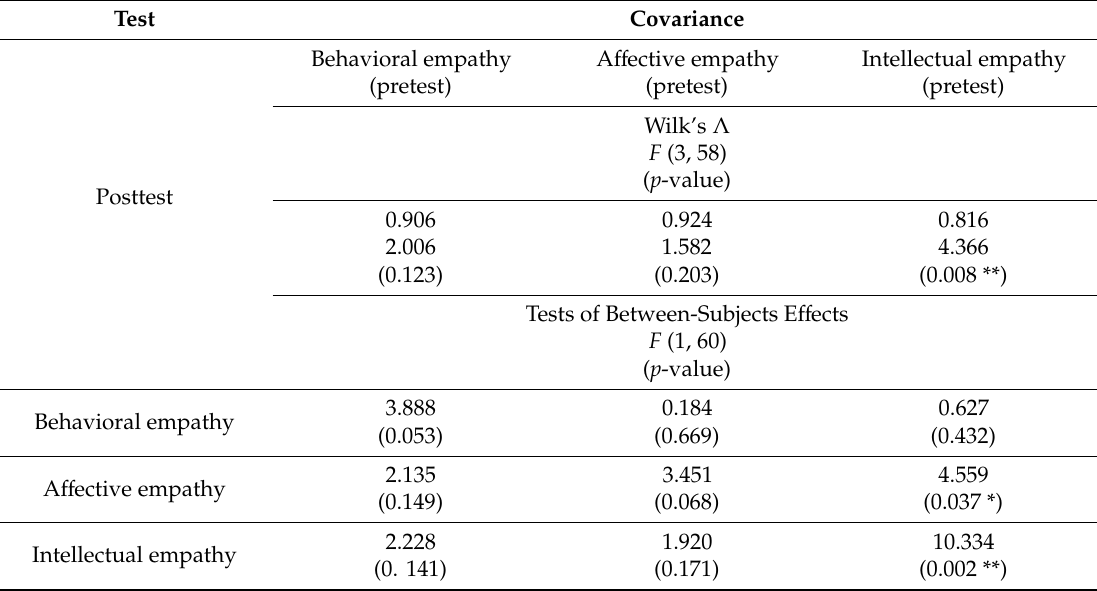
Table 7. MANCOVA results for the Empathy Scale in Patient Care (ES-PC)